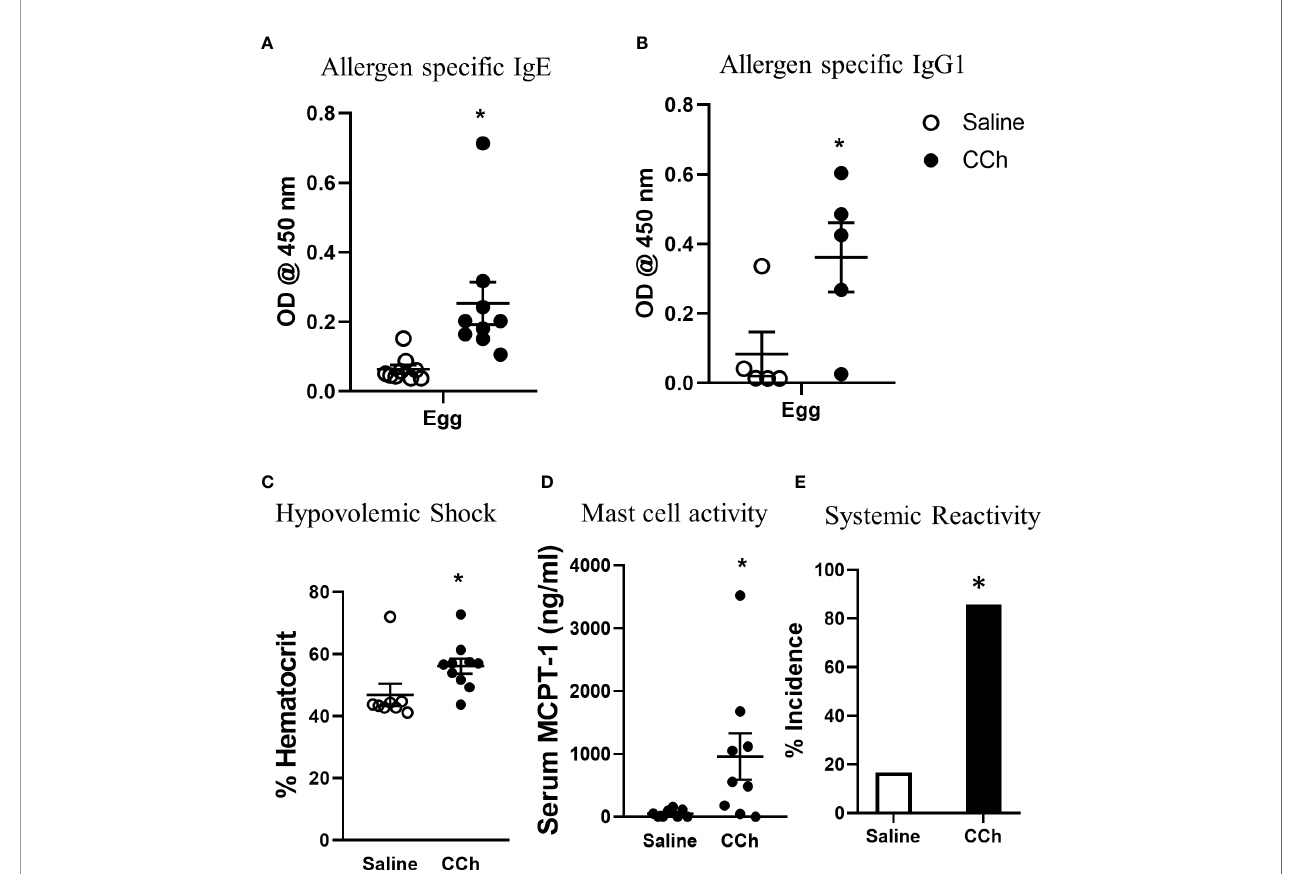
FIGURE 5 | Housing Il4ra F709 mice at thermoneutral temperature allow robust adjuvant free food sensitization upon activation of antigen passage formation. (A) allergen speci fi c IgE and (B) IgG1 in the serum of saline or CCh treated Il4ra F709 mice housed at the thermoneutral housing temperature. The graph (B) shows a representative experiment and has been repeated at least 3 times. Clinical reactivity was assessed by (C) % hematocrit and (D) serum MCPT-1 level following the systemic allergen challenge. The disease penetrance (E) was assessed by the % incidence of clinical reactivity. Fisher ’ s exact test was performed for the statistical analysis. n=5-6 per group per experiment. *denotes statistical signi fi